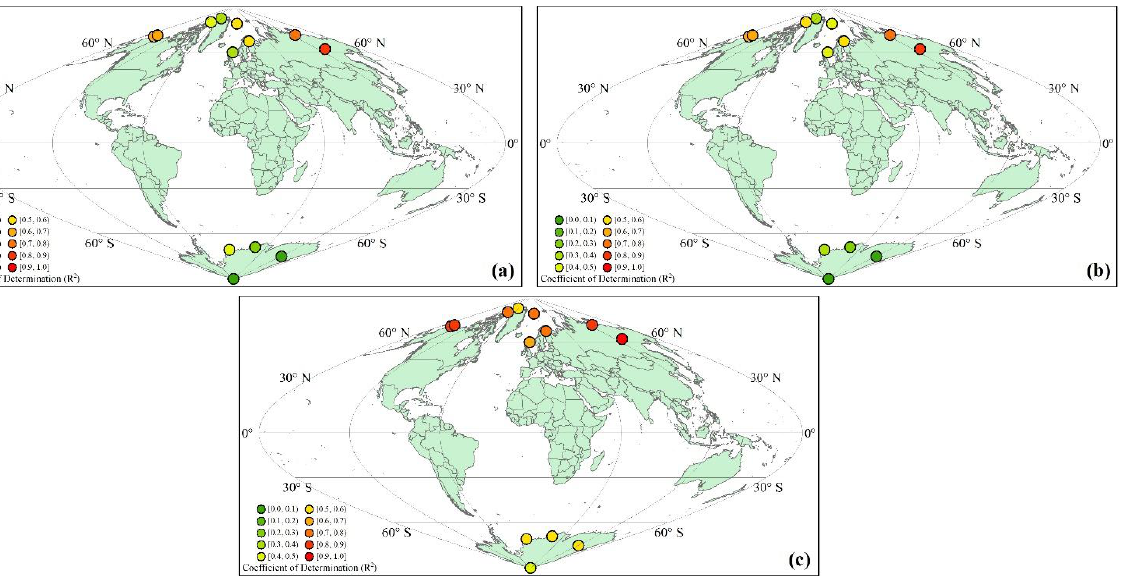
Figure 4. R 2 of 3-h DLR flux at 14 sites, ( a ) GEWEX-SRB, ( b ) ISCCP-FD, ( c ) CERES-SYN.